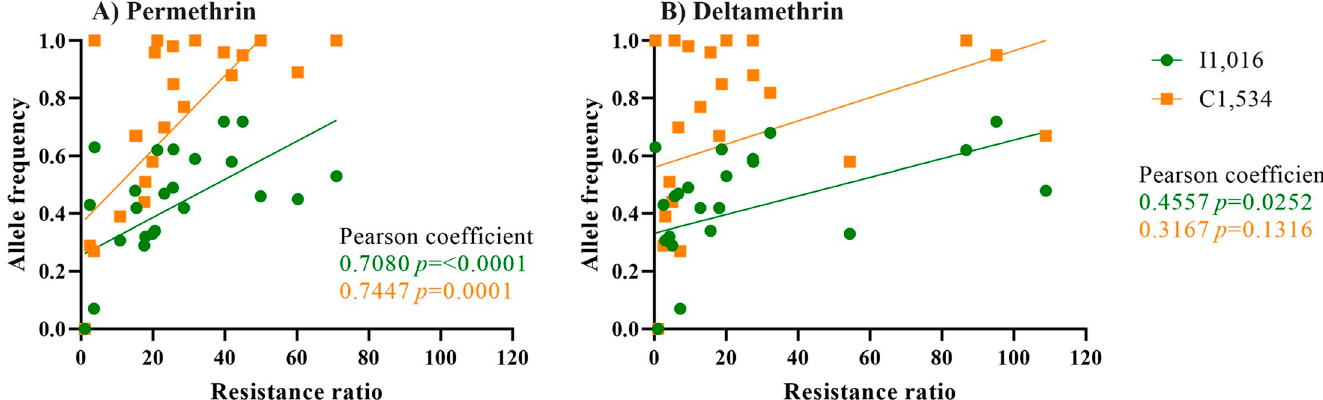
Fig 8. Correlation between the resistant alleles: I1,016 and C1,534 and the pyrethroid resistance ratio calculated for A) permethrin and B) deltamethrin.